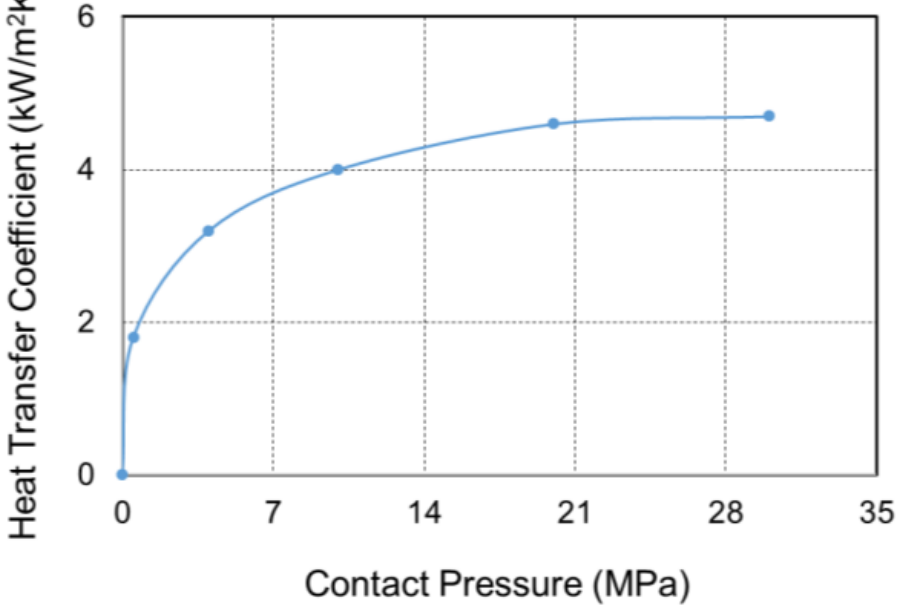
Figure 8. Interfacial heat transfer coefficient expressed as a function of contact pressure for hot stamping analysis using PAM-STAMP.